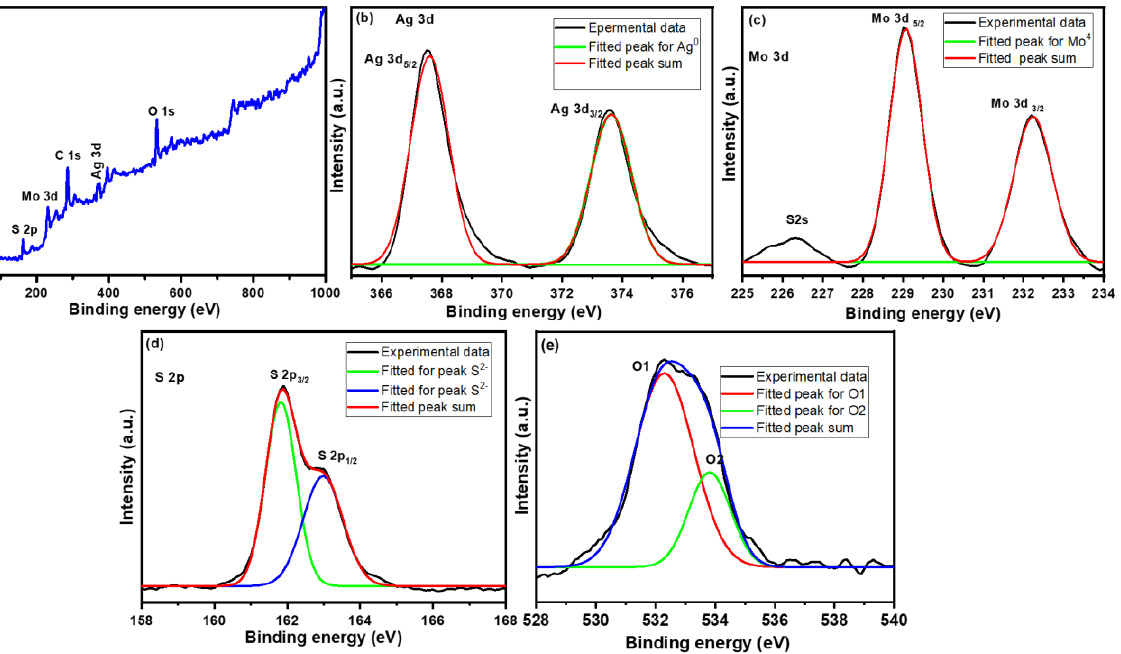
Figure 3. ( a ) X-ray photoelectron spectroscopy (XPS) spectrum of Ag/MoS 2 composite, ( b ) Ag 3d spectrum, ( c ) Mo 3sd spectrum, ( d ) S 2p spectrum, and ( e ) O 1s spectrum. spectrum, ( c ) Mo 3sd spectrum, ( d ) S 2p spectrum, and ( e ) O 1s spectrum.